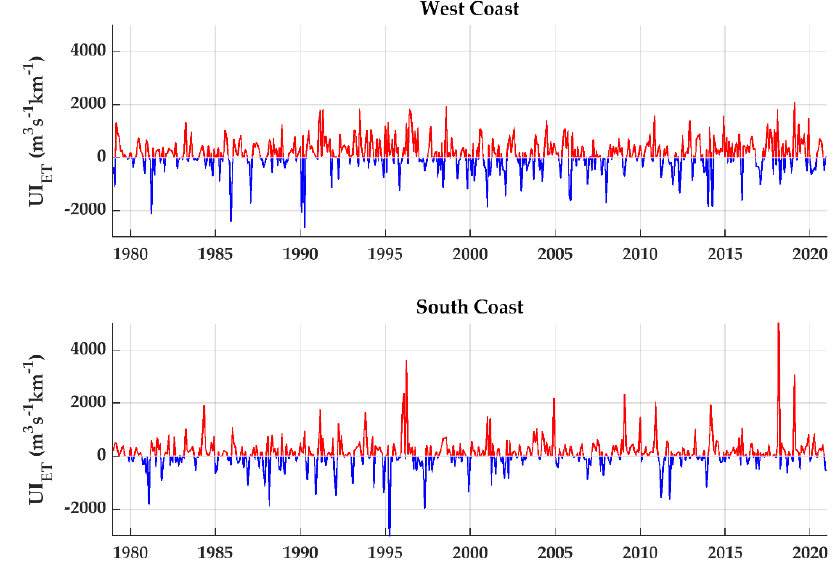
Figure 3. Evolution of UI ET (m 3 s − 1 km − 1 ) over the period 1979–2020 along the Portuguese ( a ) west coast and ( b ) south coast.